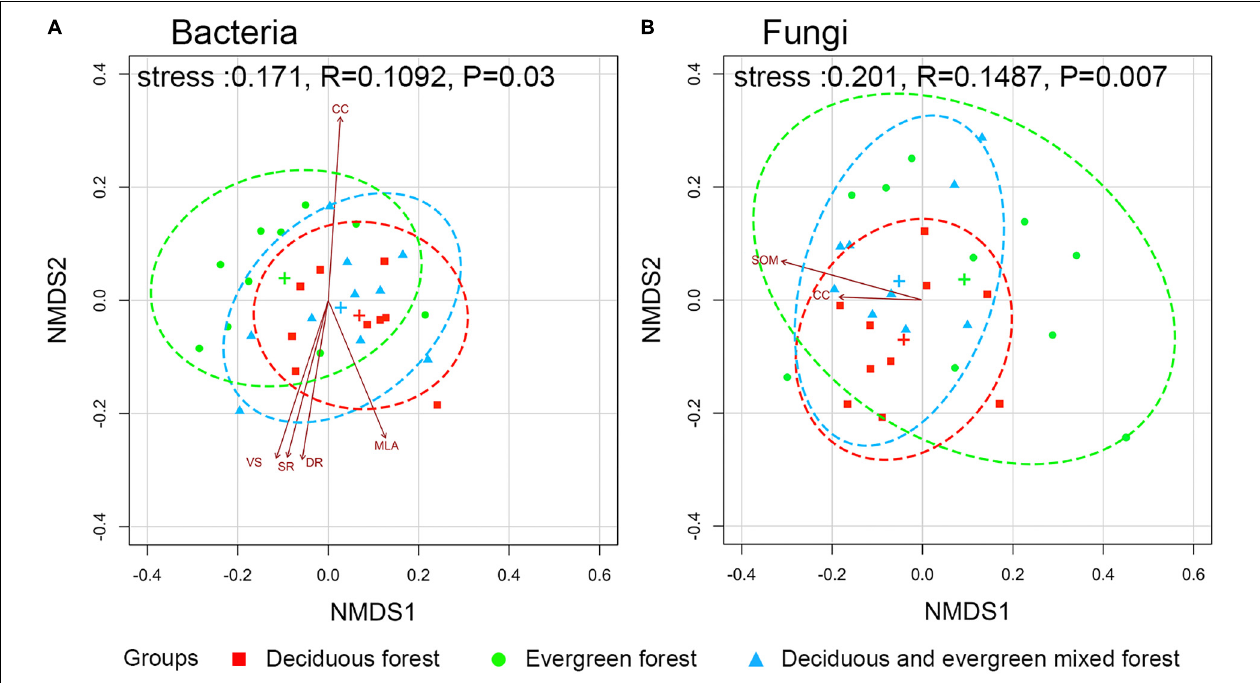
FIGURE 5 | Ordination plot of bacterial (A) and fungal (B) communities from non-metric multidimensional scaling analysis based on unifrac dissimilarities among different vegetation types. (The ellipses are the 95% confidence interval, and the significance between communities was evaluated by permutational multivariate analyses of variance. The relationships between the community and environmental factors only show strongly correlated ( p ≤ 0.05) variables. SOM, soil organic matter; CC, canopy cover degrees; VS, total transmission ratio; SR, scatter radiation under the canopy; DR, direct radiation under the canopy; MLA, mean leaf angle.)